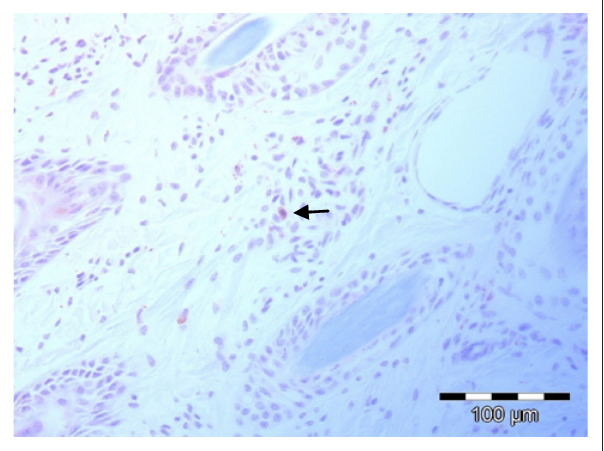
FIGURE 7: Nonspecific positive NovaRED staining of mast cells in the dermis (arrow; magnification: 40x).